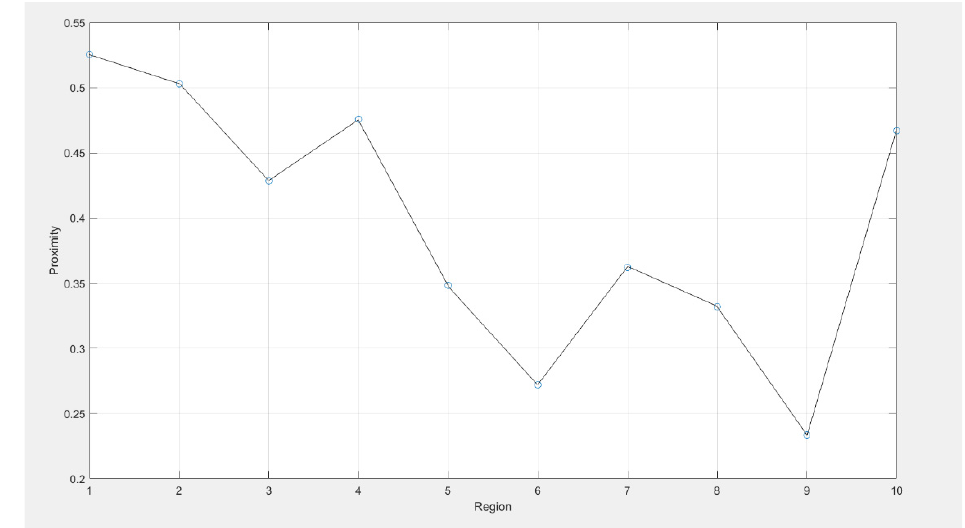
Figure 1. The proximity of each district.